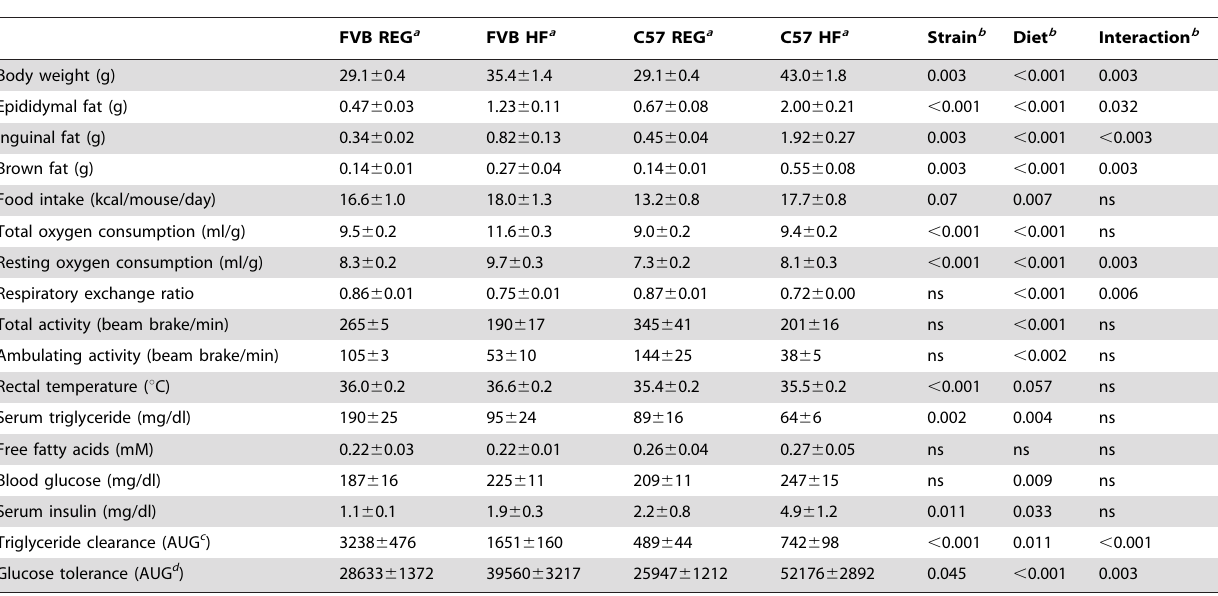
Table 1. Characteristics of FVB and C57 mice after 12 weeks of high-fat and control feeding.